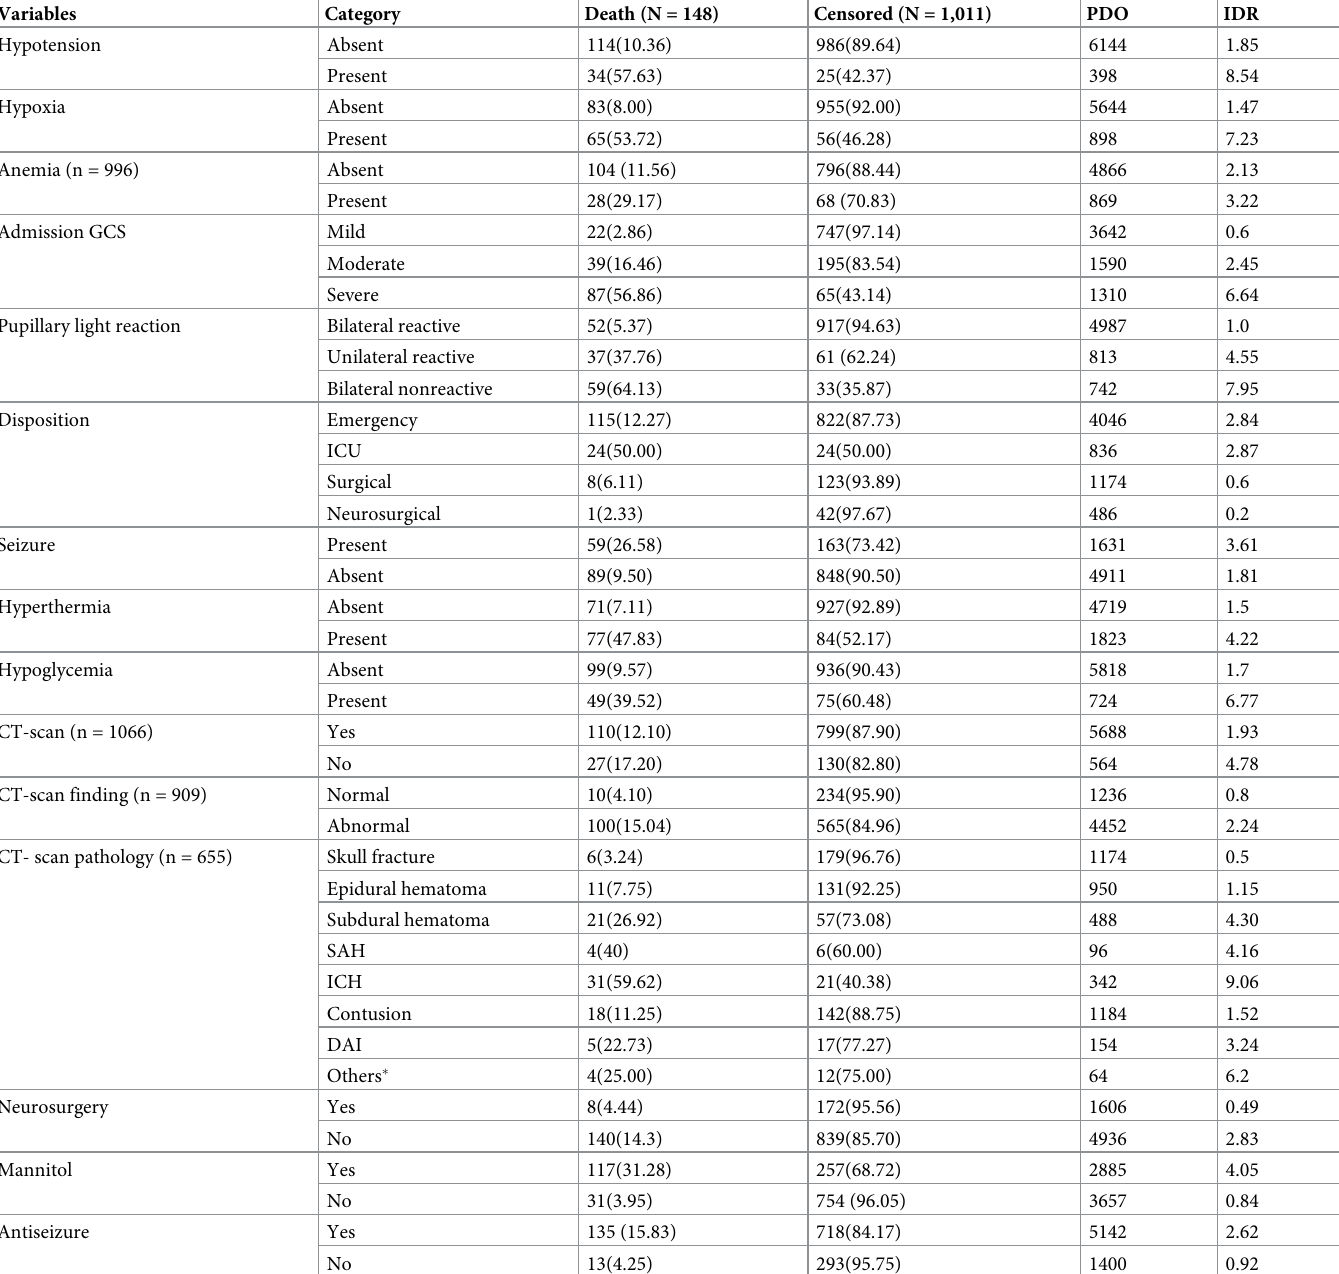
Table 2. Baseline clinical and management related characteristics of head injury patients admitted to HUCSH from July 2017- July 2019, Hawassa, southern